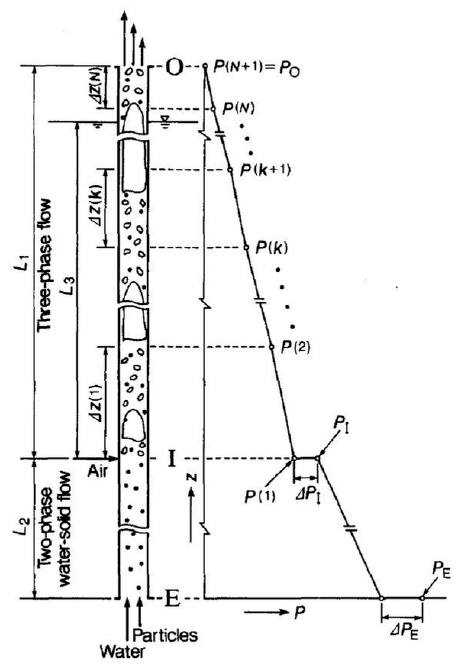
Figure 1. The schematic diagram of an airlifting system [6].